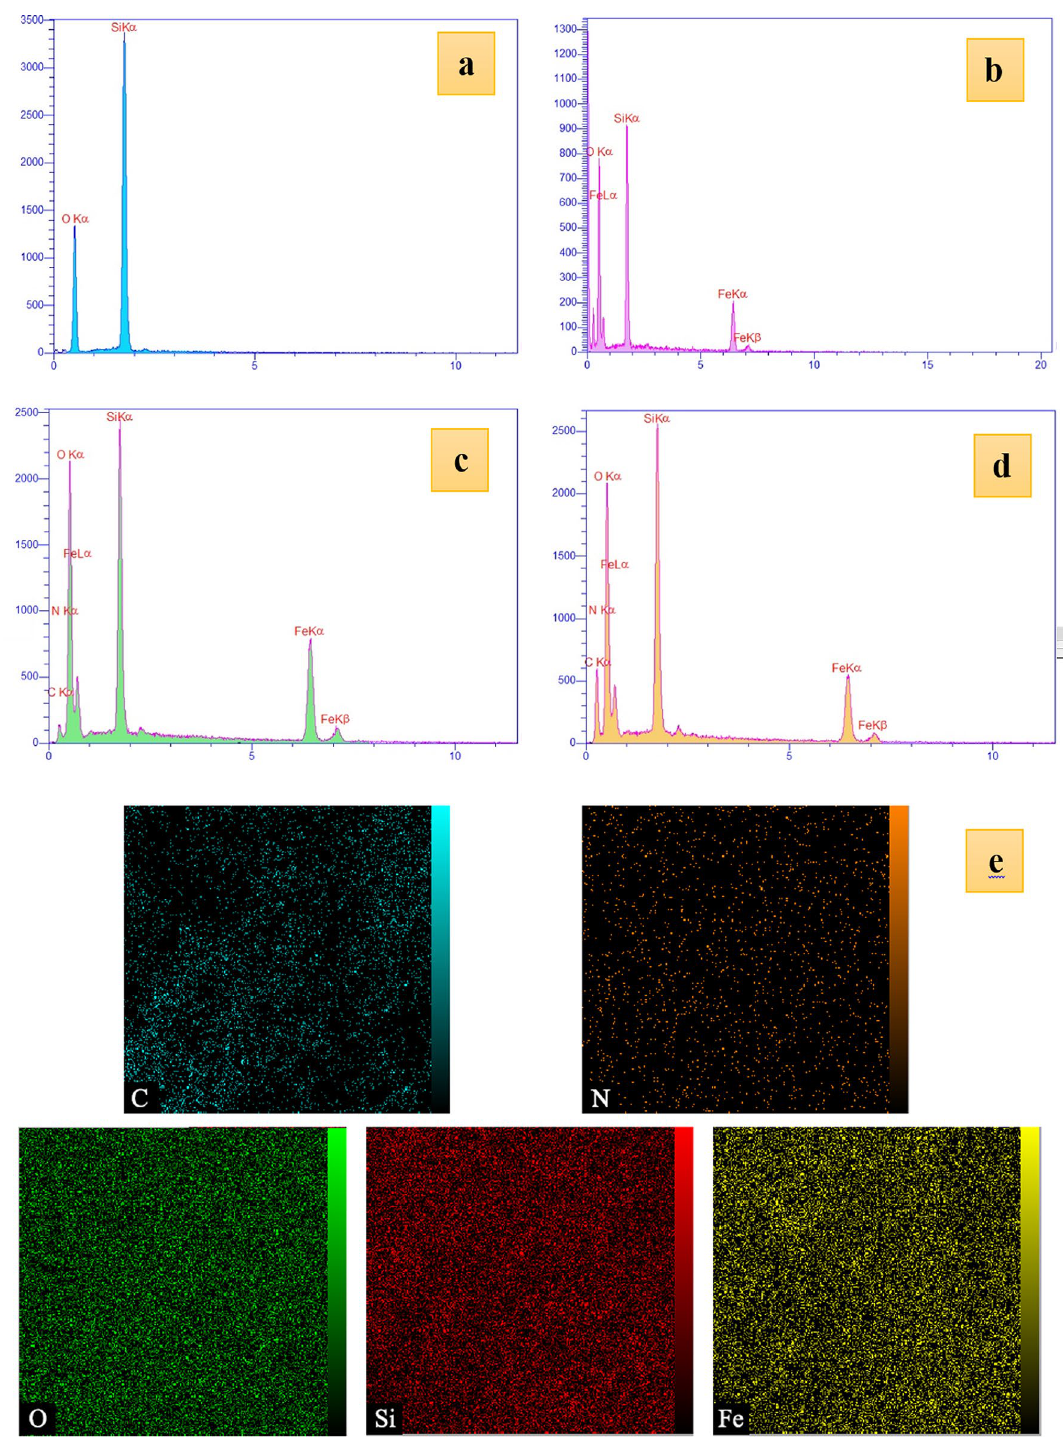
Figure 3. EDX analyses of ( a ) SBA-15 , ( b ) SBA-15/Fe 3 O 4, ( c ) APTES@ SBA-15/Fe 3 O 4 , ( d ) guanidinylated SBA- 15/Fe 3 O 4 , ( e ) and mapping images of the guanidinylated SBA-15/Fe 3 O 4